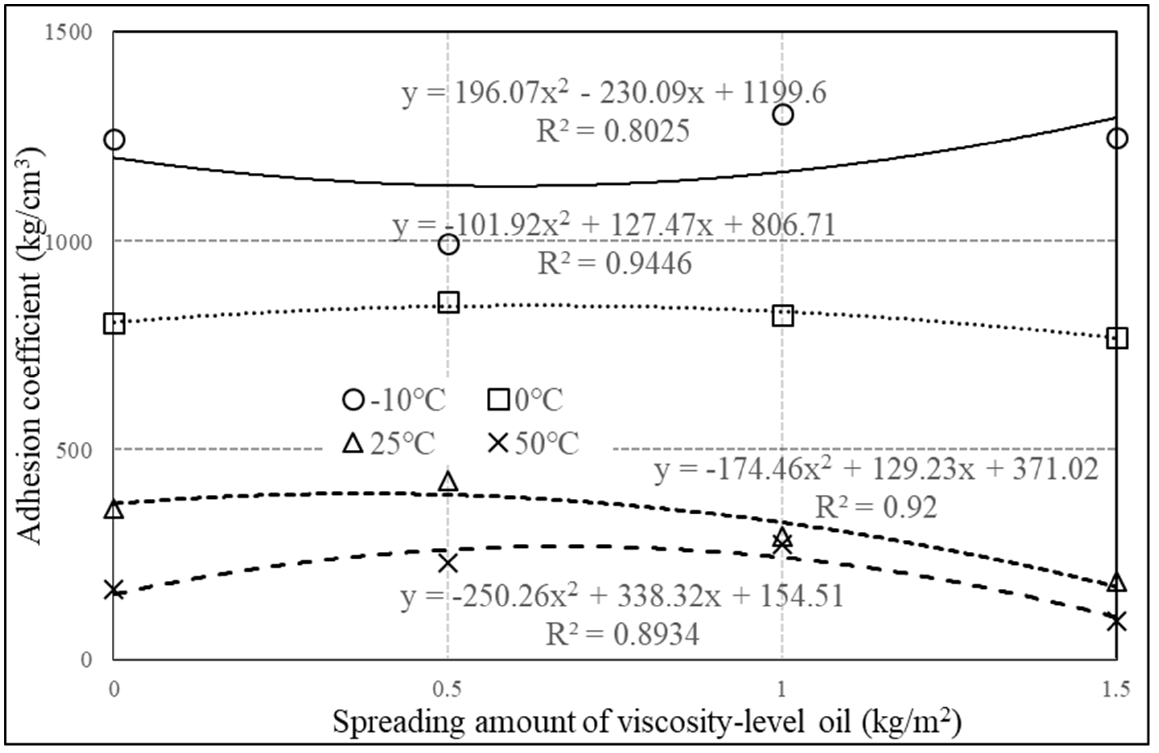
K Figure 17. The curves of AC-20/AC-25. Figure 17. The K max curves of AC-20/AC-25. max Table 11. Optimum amount of viscosity oil spread. Temperature Viscosity Oil A